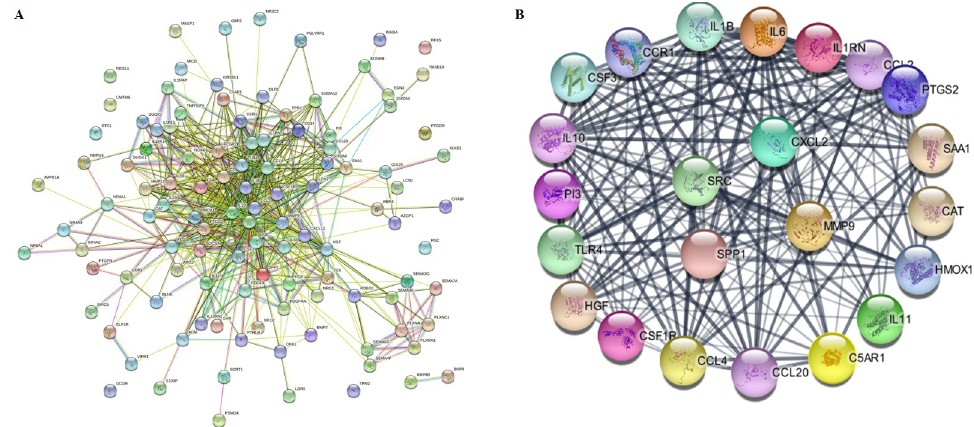
Fig 4. The protein-protein interaction (PPI) network of 112 immune-related differently expressed genes. The hub proteins were selected based on the topological parameter (degree > 21). (A) The PPI network was generated using STRING. (B) The main module showed four hub genes in the center by MCODE plugin in the Cytoscape.